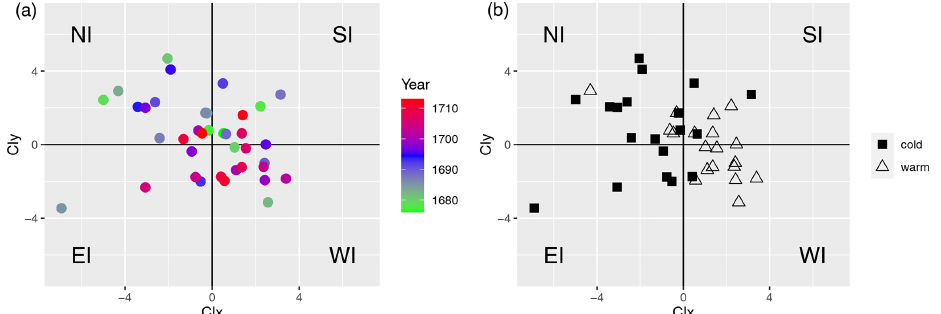
Figure 12. (a) Scatterplot of the CI for the LMM winters, with colors indicating the year within the LMM. The x axis represents the CI x coordinate of the CI and the y axis the CI y coordinate of the CI. (b) As in panel (a) but showing two different clusters; squares are below the median of T mean and triangles are above the median of T mean .